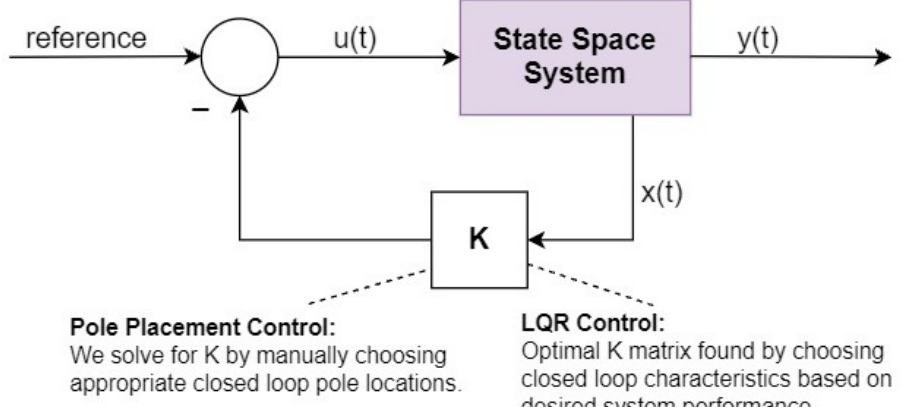
Figure 3. Full state feedback control—pole placement and